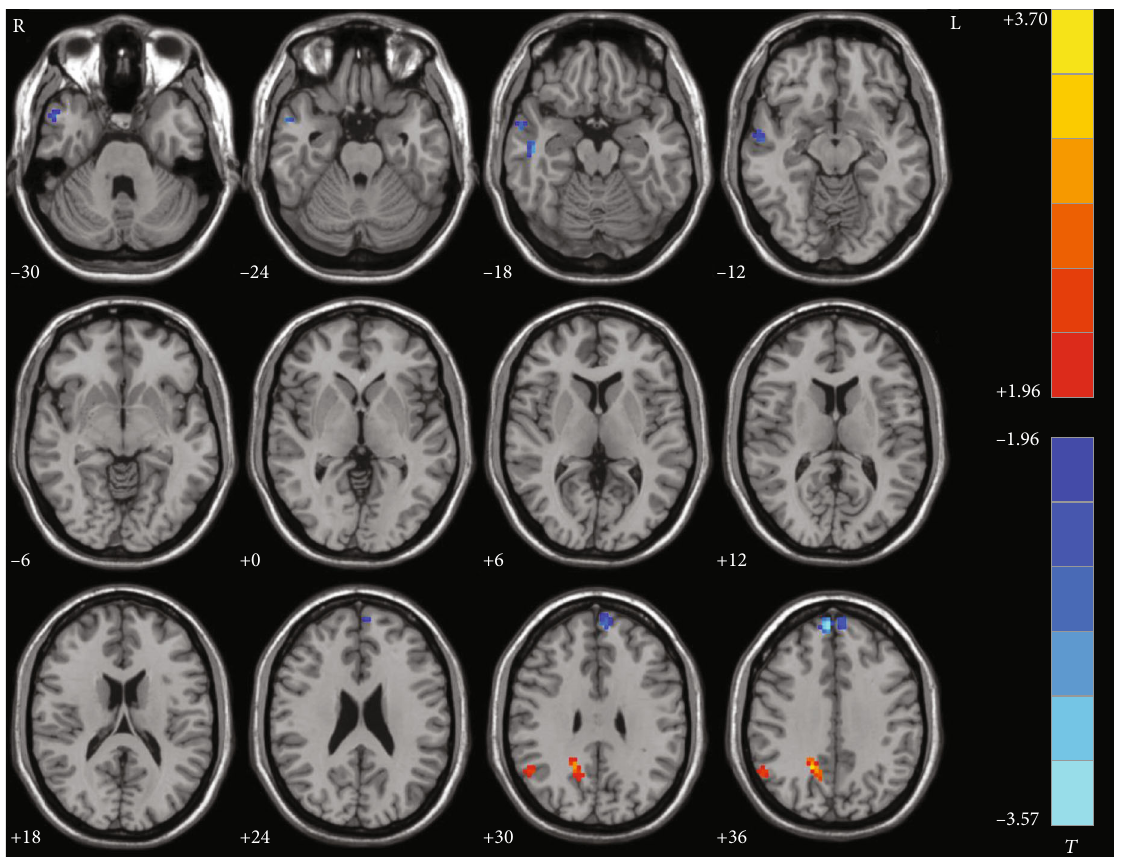
Figure 3: Statistical map depicts higher and lower NH of nonmelancholic patients compared with healthy controls. The threshold was set at p < 0 : 05 . Blue denotes lower NH and red denotes higher NH. Color bar indicates T values from two-sample t -test. L: left side; R: right side; DMN: default mode network; NH: network